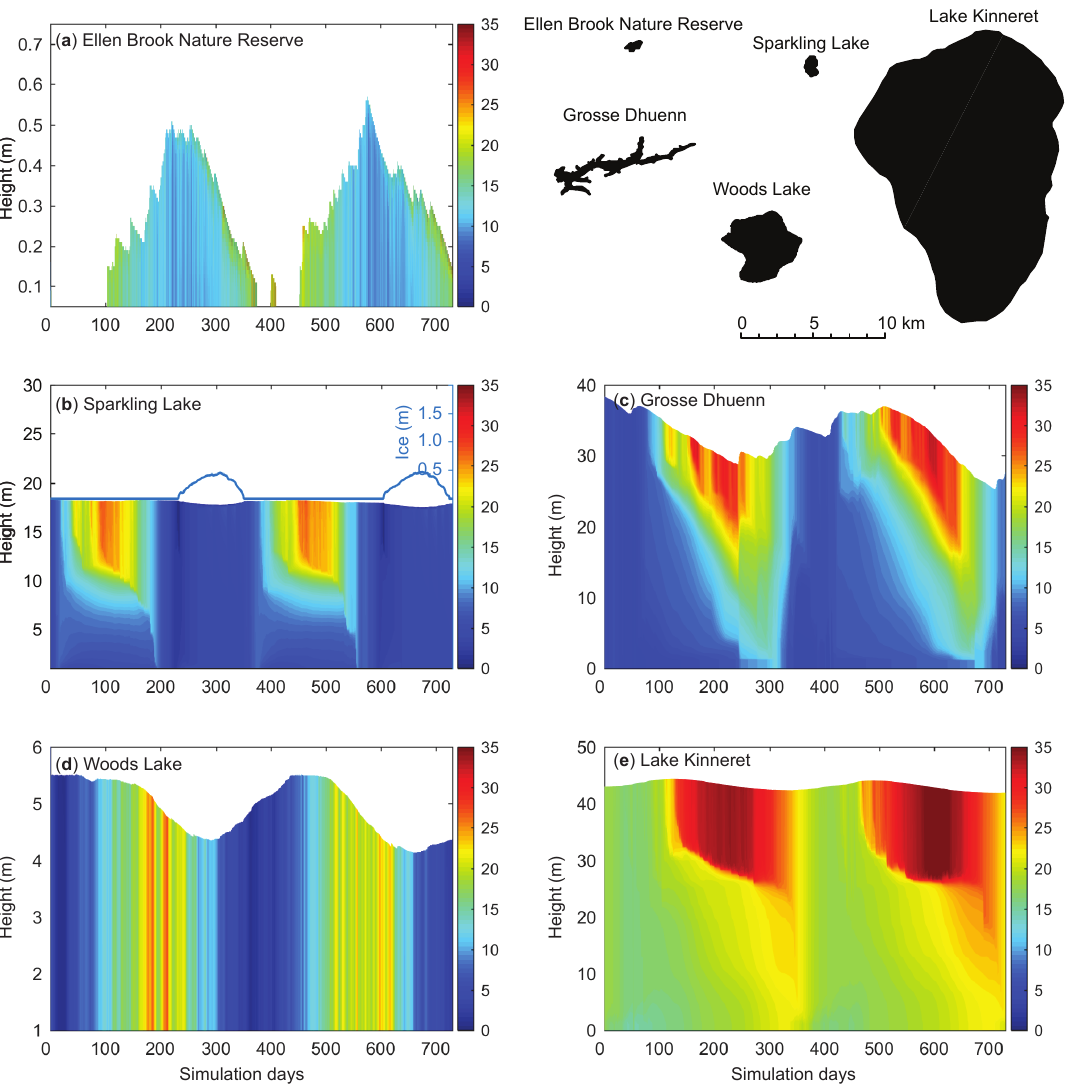
Figure 9. A 2-year time series of the simulated temperature profiles for five example lakes (a–e) that range in size and hydrology. For more information about each lake and the simulation configuration, refer to the “Data availability” section (refer also to Figs. 2 and 5). Sparkling Lake (b) also indicates the simulated depth of ice on the RHS